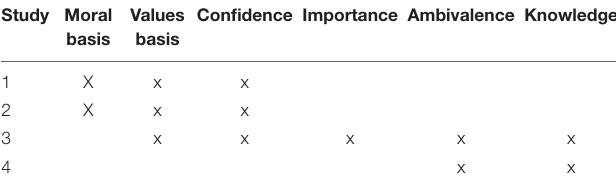
TABLE 1 | Summary of all attitude strength-related features measured in each study. Study Moral Values Confidence Importance Ambivalence Knowledge basis basis